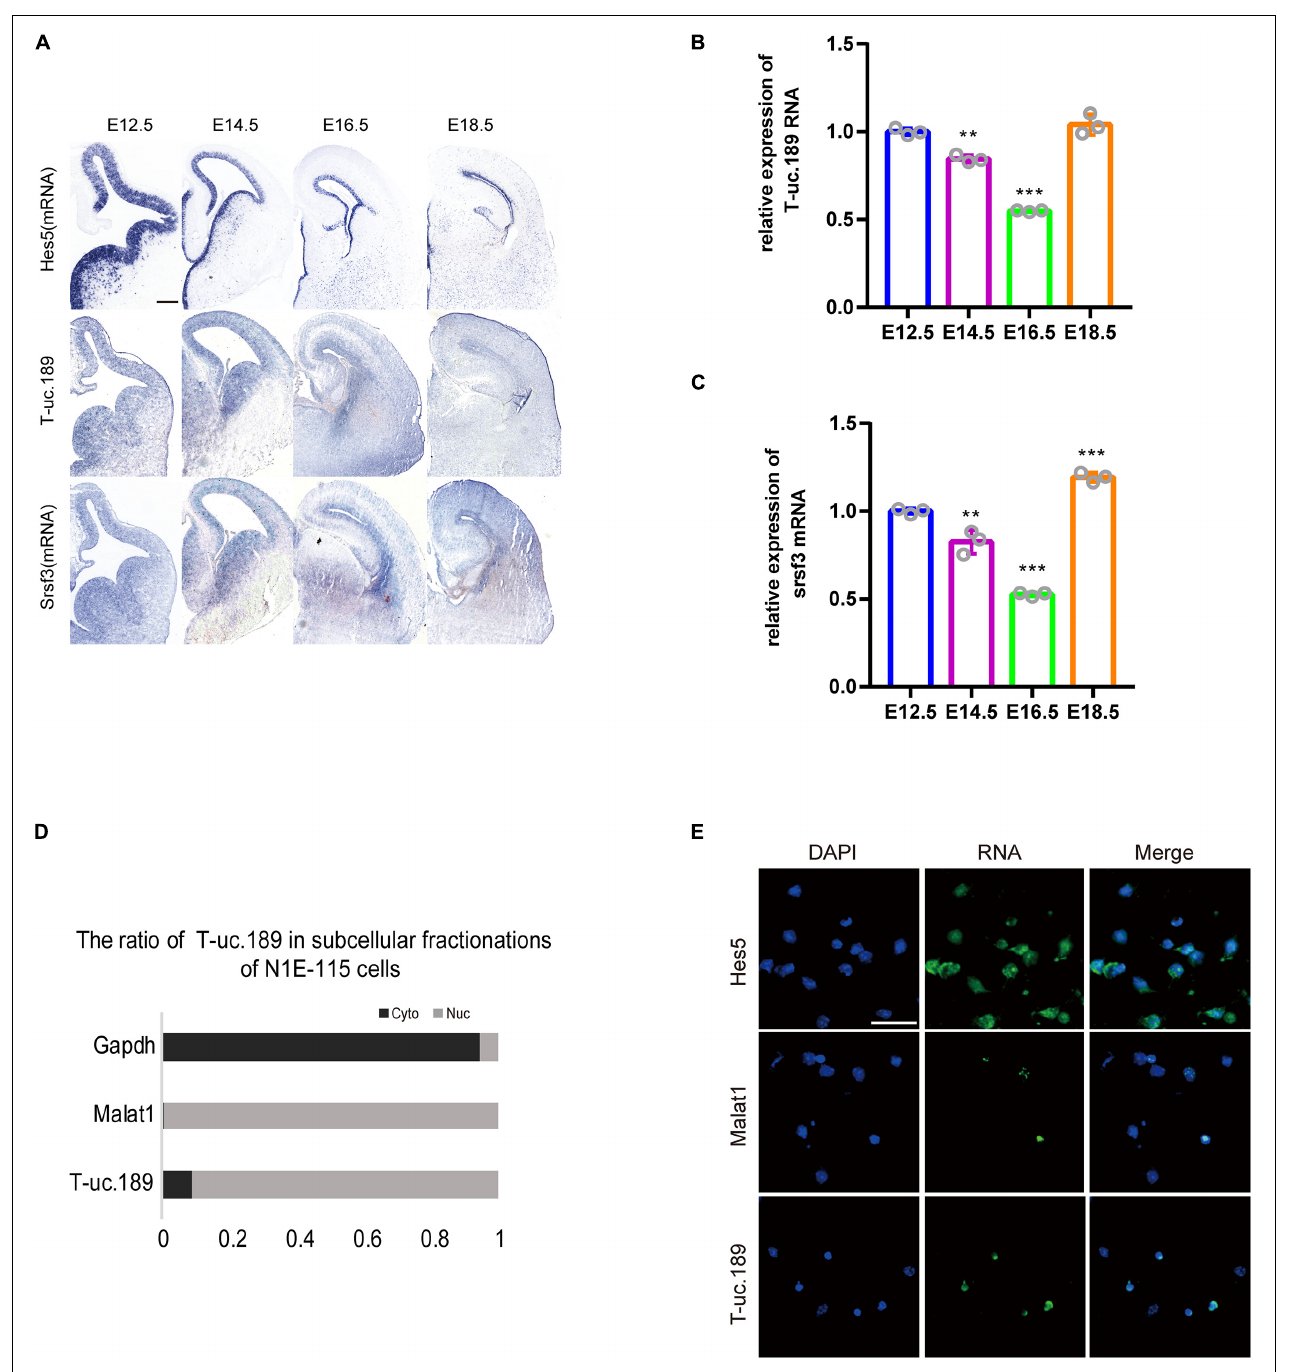
FIGURE 2 | Expression pattern of T-uc.189. (A) In mouse fetal brains at E12.5, E14.5, E16.5 and E18.5, the spatiotemporal expression patterns of T-uc.189 and Srsf3 were determined by RNA in situ hybridization, and Hes5 served as a positive control. The scale bar is 200 µ m. (B,C) The relative expression of T-uc.189 and Srsf3 were detected by real-time PCR on fetal mouse brains at different stages (E12.5, E14.5, E16.5, E18.5). (D) Nucleocytoplasmic separation experiments were performed in NIE-115 cells to determine the distribution of T-uc.189. (E) Combined immunofluorescence/RNA fluorescence in situ hybridization (IF/RNA FISH) was performed to detect the subcellular localization of T-uc.189 in neural stem cells. The scale bar is 30 µ m. n ≥ 3 independent biological repeats. The results are expressed as the mean ± SD, and comparisons were performed by ANOVA. The statistically significant P values are shown as ** P < 0.01 or *** P < 0.001.